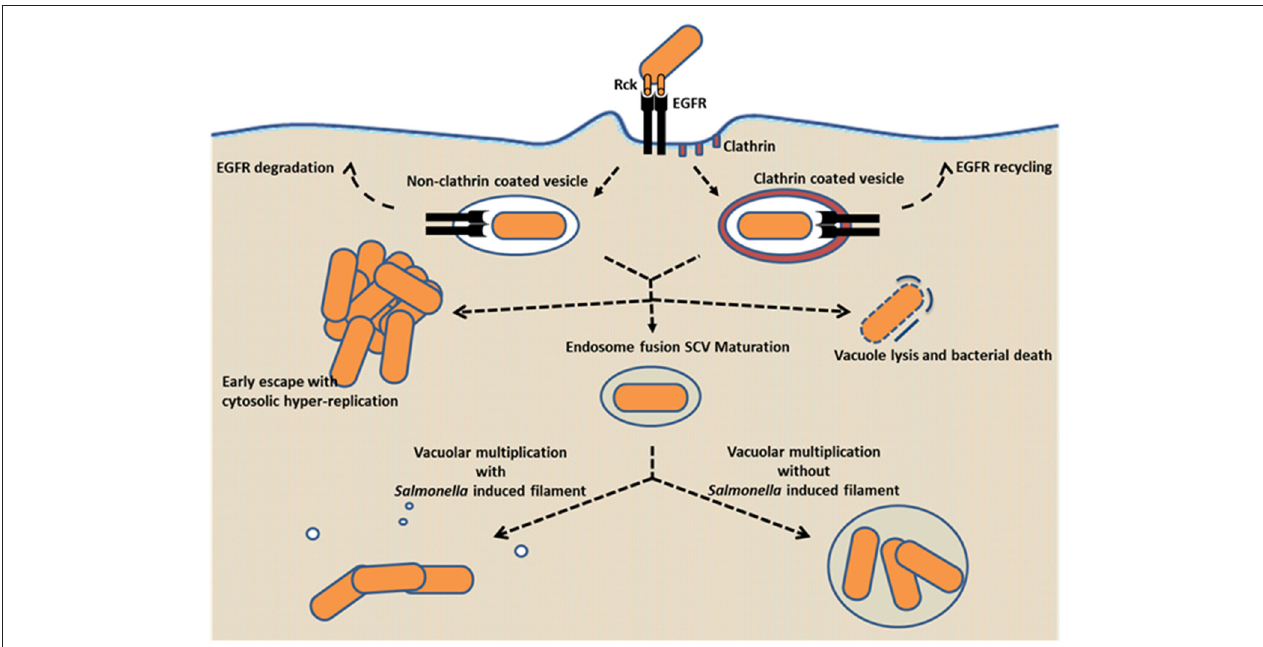
FIGURE 4 | Potential intracellular behaviors of Salmonella following Rck-mediated invasion. Rck interaction with EGFR could lead to internalization of Salmonella in non-clathrin or clathrin-coated vesicule. Then vacuole escape or vacuole lysis could lead to Salmonella cytosolic hyper-replication or bacterial death respectively. As commonly described, expression of T3SS-1 effectors relayed by expression of T3SS-2 effectors allows vacuole maturation leading to Salmonella multiplication in vacuole with or without SIF formation. Dotted arrows represent the potential